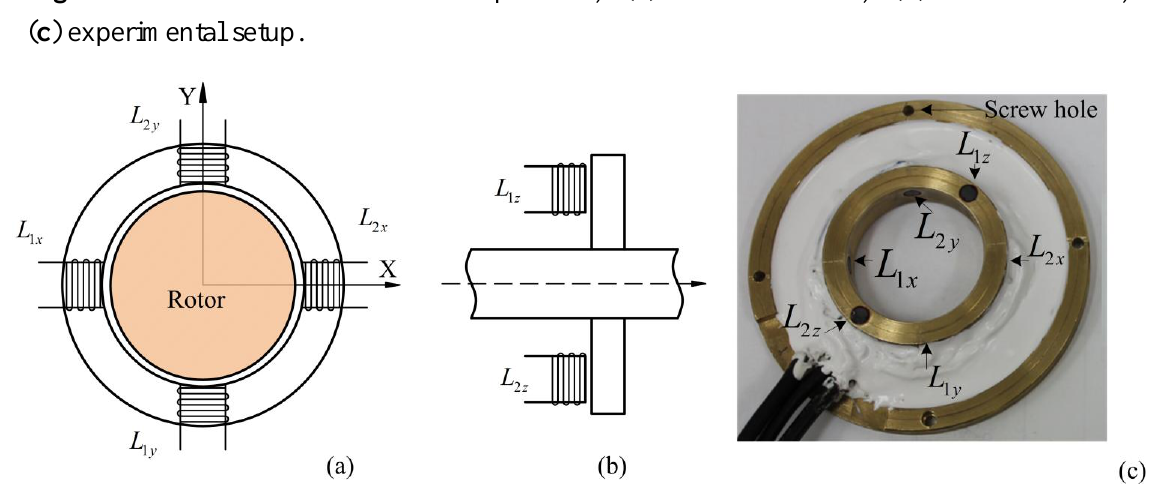
Figure 9. The Wheatstone bridges equivalent diagram, ( a ) x axis differential